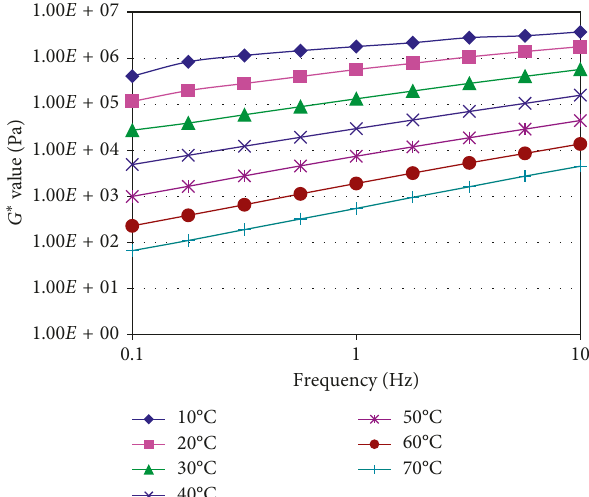
Figure 15: G value versus loading frequency for the stone sawdust mastic (VR 0.05). ∗ (cid:30)